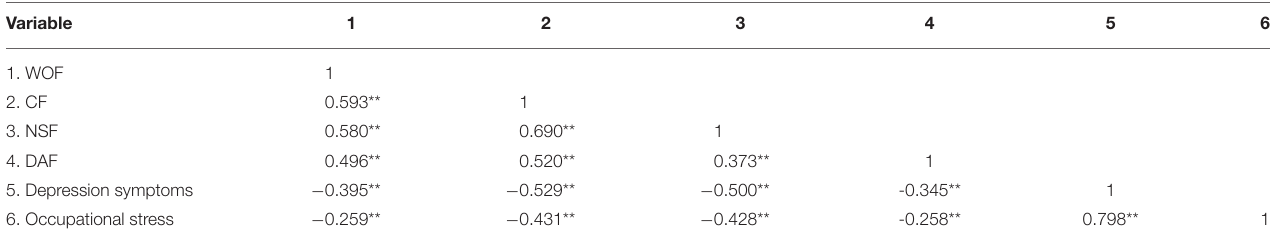
WOF, worker-occupation fit; CF, Characteristic fit; NSF, need supply fit; DAF, demand ability fit. ** Correlation is significant at the 0.001 level